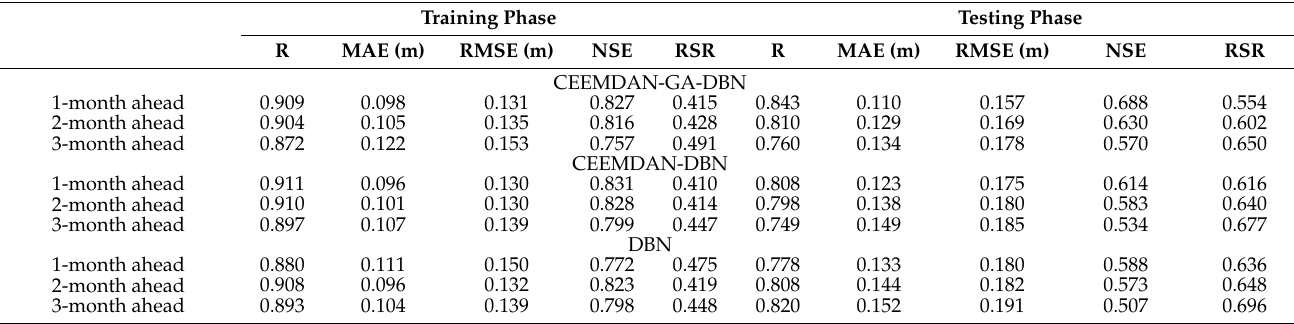
Table 5. Performance metrics of the hybridized CEEMDAN-GA-DBN, CEEMDAN-DBN and DBN models in the training and testing phases for 1-, 2- and 3-month ahead GWL forecasting of Well